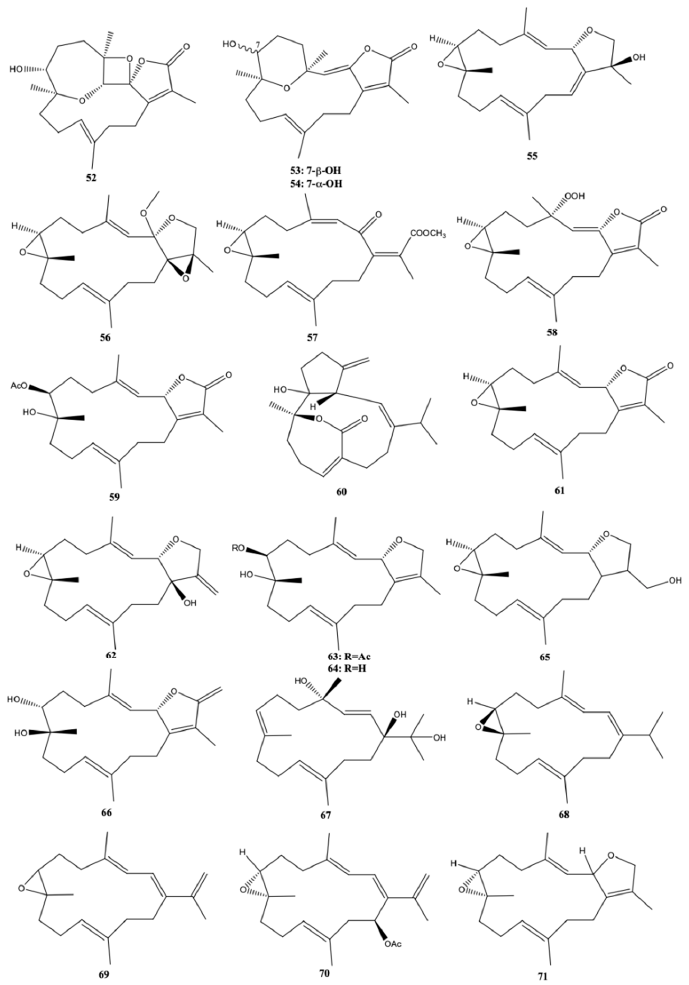
Figure 7. Cembranoid diterpenes isolated from S. stellatum , from the coast of Dongsha Atoll, Taiwan [33] and coast of Madagascar [24].